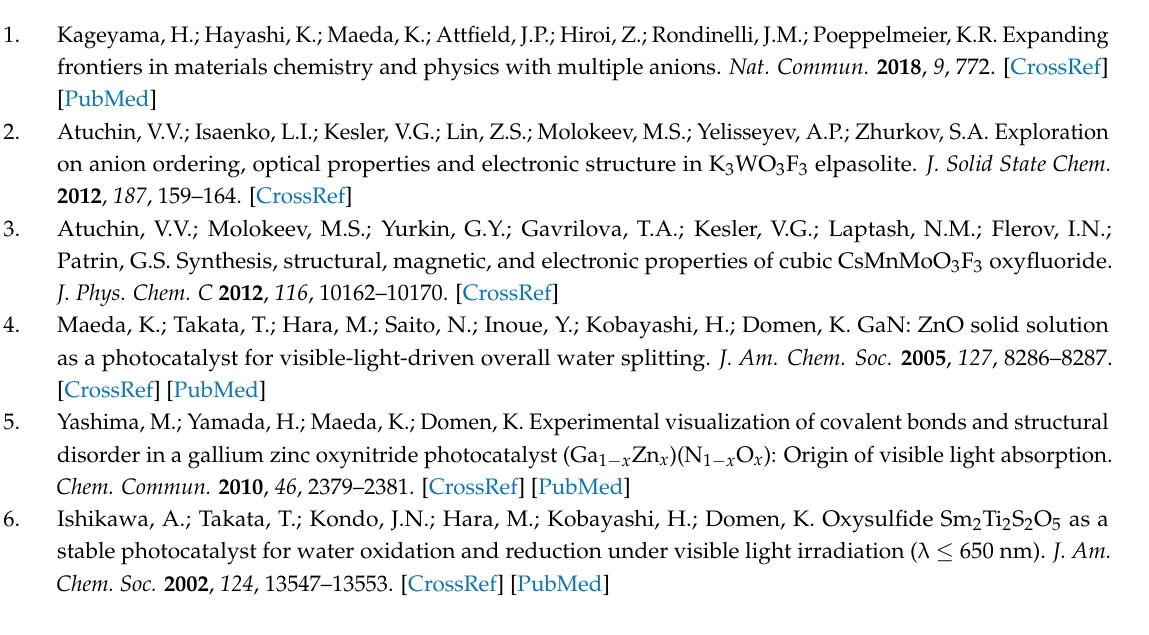
Figure S1: Powder XRD of obtained product when using reported condition, Figure S2: A picture of obtained product with grey agglomerate and yellow crystalline mass, Figure S3: EDX spectra of (a) Bi 4 NbO 8 Cl and (b) Bi 4 NbO 8 Br crystal, Table S1: Refined structural parameters for Bi 4 NbO 8 Cl at 293 K in the space group P 2 1 cn , Table S2: Selected bond lengths and angles for Bi 4 NbO 8 Cl. Table S3: Calculated bond valence sum values of Bi 4 NbO 8 Cl, Figure S4: Polarized Raman spectra of Bi 4 NbO 8 Cl in cross nicol geometries, Figure S5: Reciprocal lattice plane of Bi 4 NbO 8 Br. Table S4: Refined structural parameters for Bi 4 NbO 8 Br at 293 K in the space group P 2 1 cn . Lattice parameters: a = 5.51190(10) Å, b = 5.51190(10) Å, c = 29.0984(14) Å, Table S5: Selected bond lengths and angles for Bi 4 NbO 8 Br, Table S6: Crystallographic data for Bi 4 NbO 8 Cl and Bi 4 NbO 8